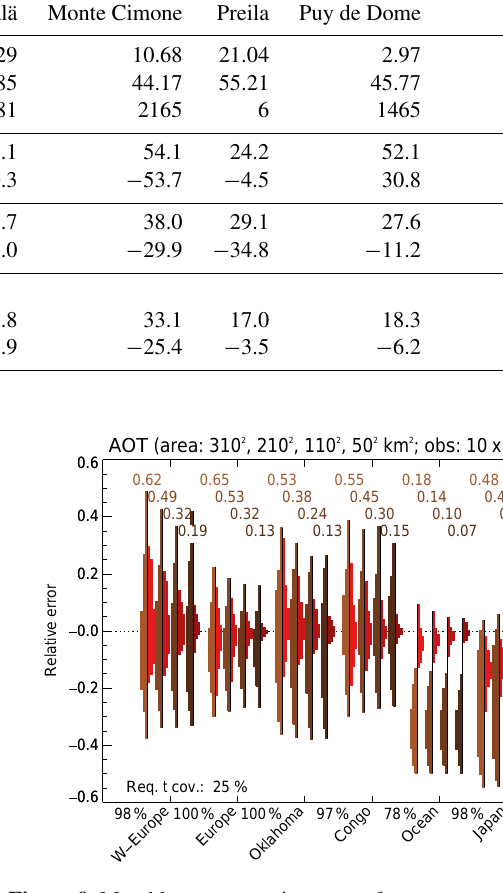
Figure 9. Monthly representation errors for remote sensing ground sites at different area sizes: no collocation (different shades of brown) and model data collocated to the hour (different shades of red). Further explanation in Sect.